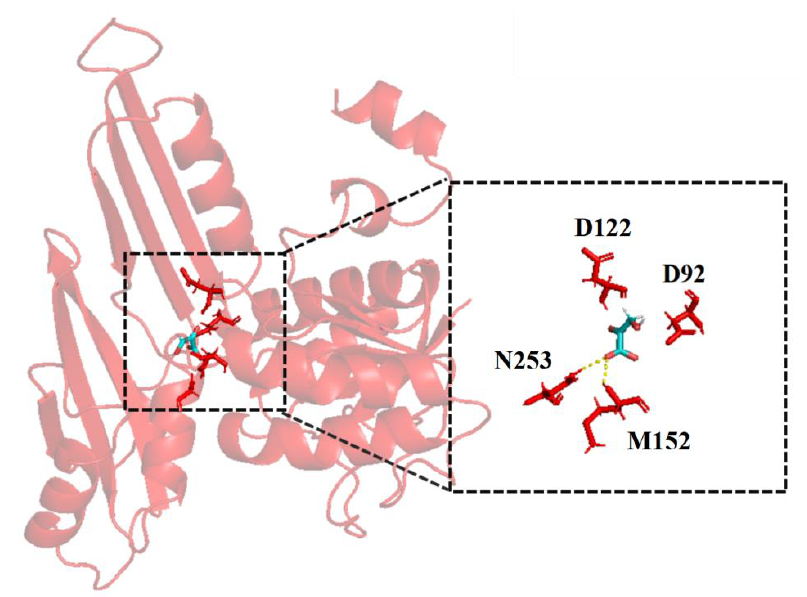
Figure 2. The docking results of hydroxypyruvate with the StDAPDH/H227V model.